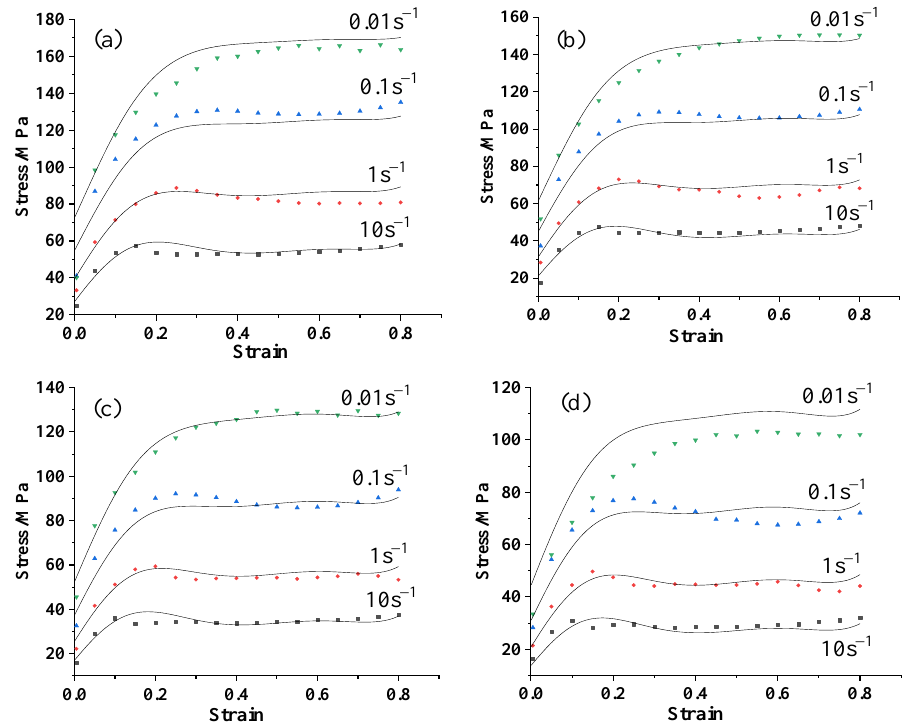
Figure 7. Comparison of theoretical and experimental values of the constitutive equation with strain correction: ( a ) 1273 K, ( b ) 1323 K, ( c ) 1373 K, and ( d ) 1423 K.